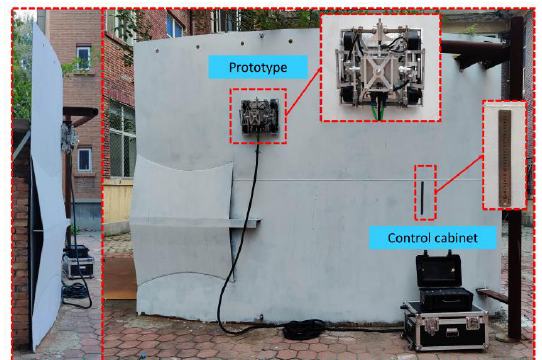
Figure 11. Experimental scene.